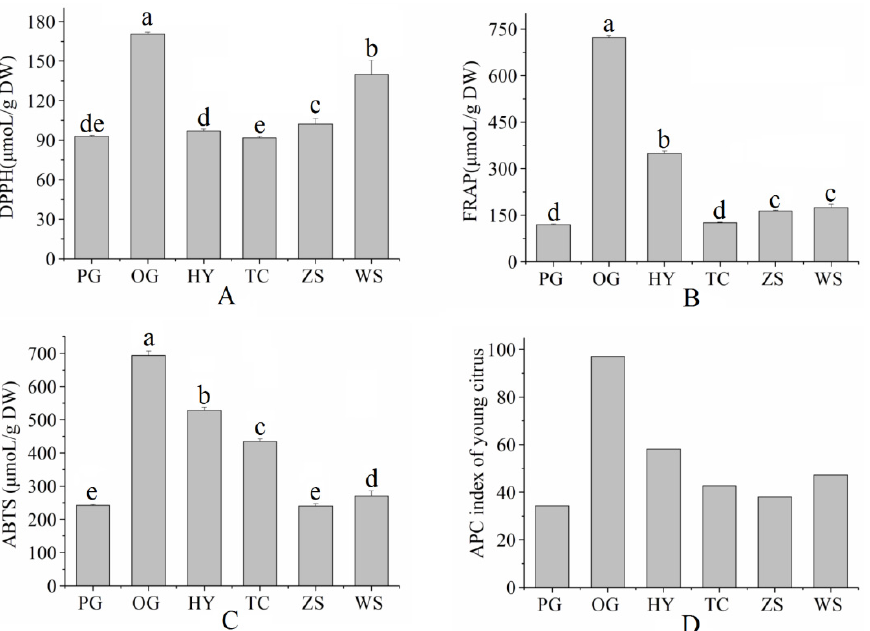
Figure 2. Antioxidant activity determined by DPPH ( A ), FRAP ( B ), ABTS ( C ) and their APC indexes ( D ) of young citrus (PG: Ponkan; OG: Ougan; HY;Huyou; TC: Tiancheng; ZS: Zaoshuwenzhoumigan; WS: Wanshuwenzhoumigan; a–e in each row indicated significant difference at 0.05 levels). Table 3. Correlation analysis of antioxidant abilities in young fruits of citrus. Total Total Synephrine Phenolic Flavonoid